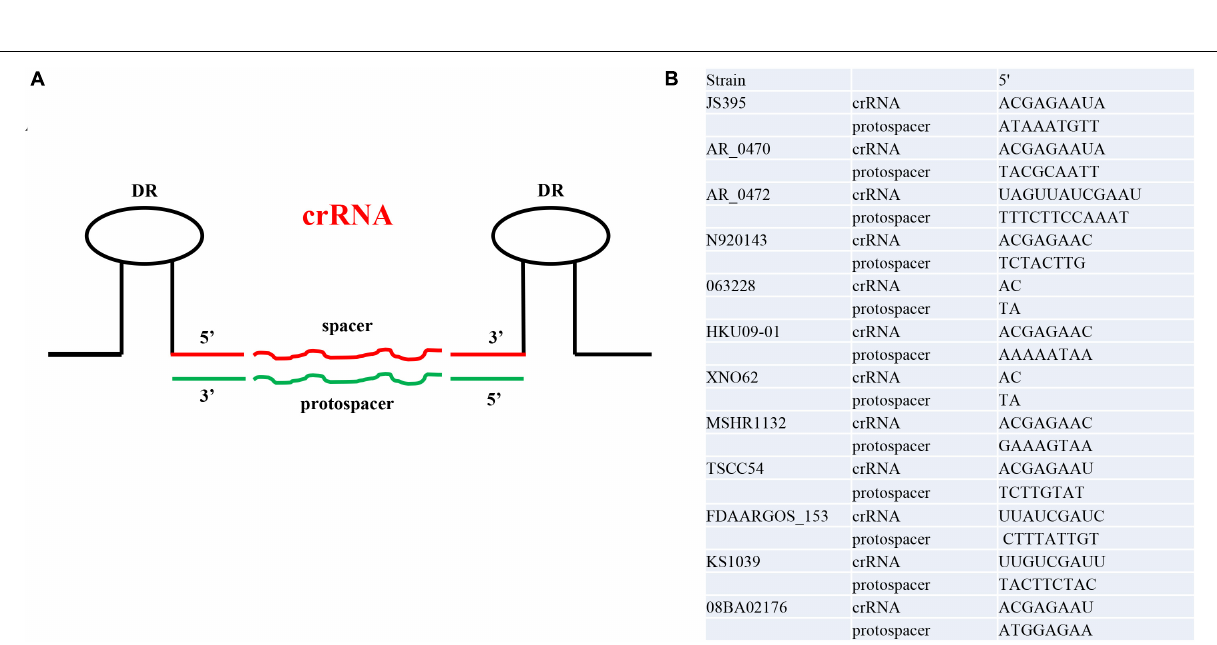
Frontiers in Microbiology |